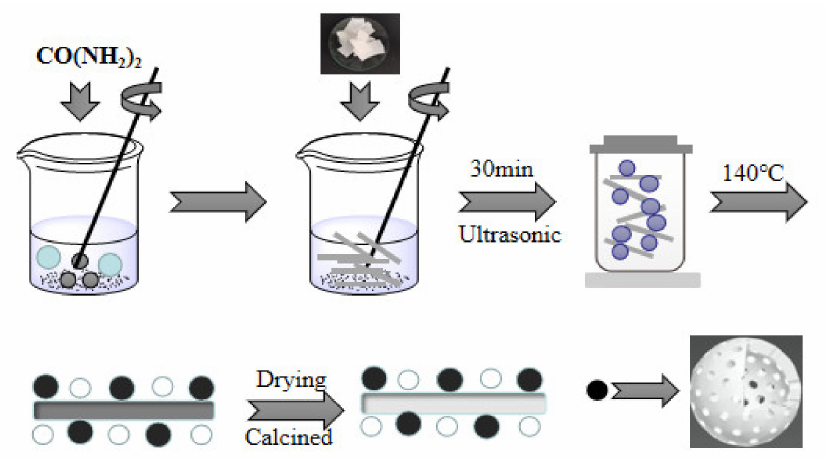
Figure 1. Preparation flow chart of Mg-Al metal